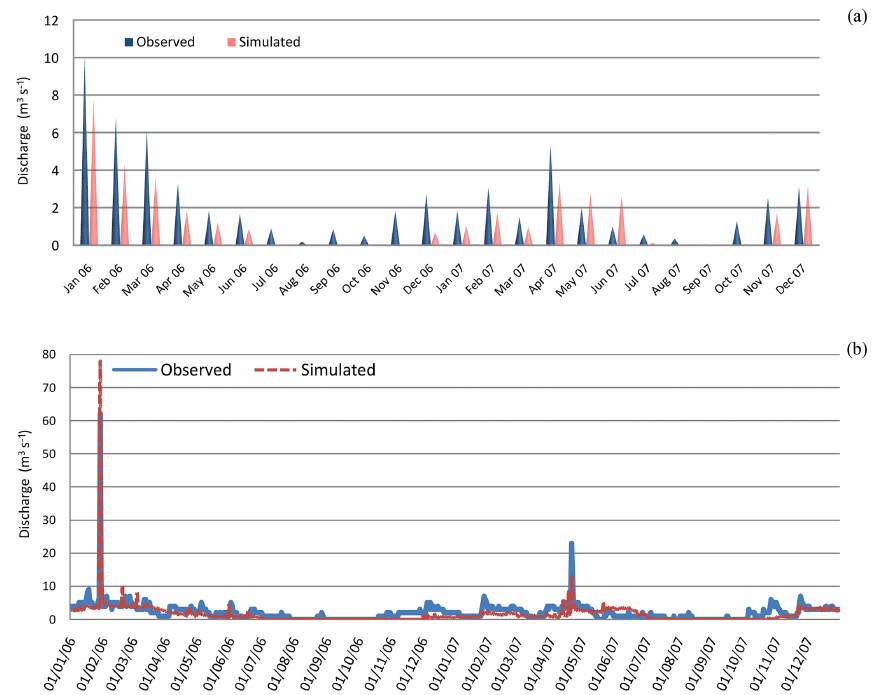
Figure 2. Observed Vs simulated monthly (a) and daily (b) discharge after manual calibration at the Souk Elhad flow gage.